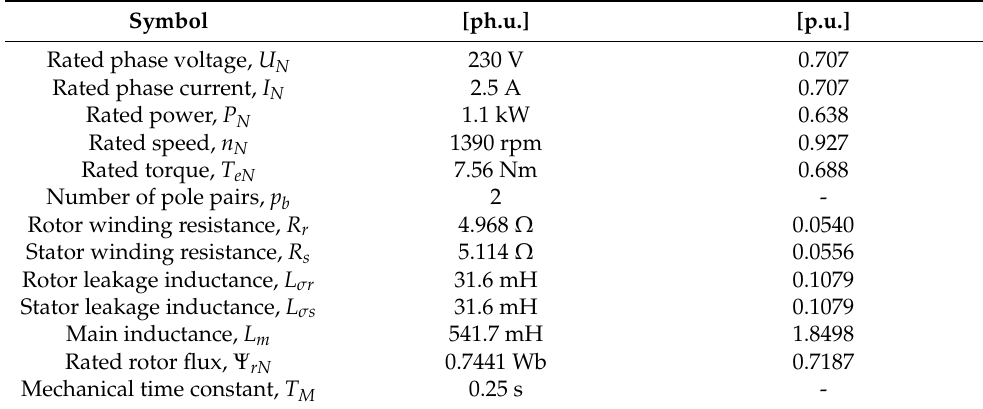
Table A1. Induction motor